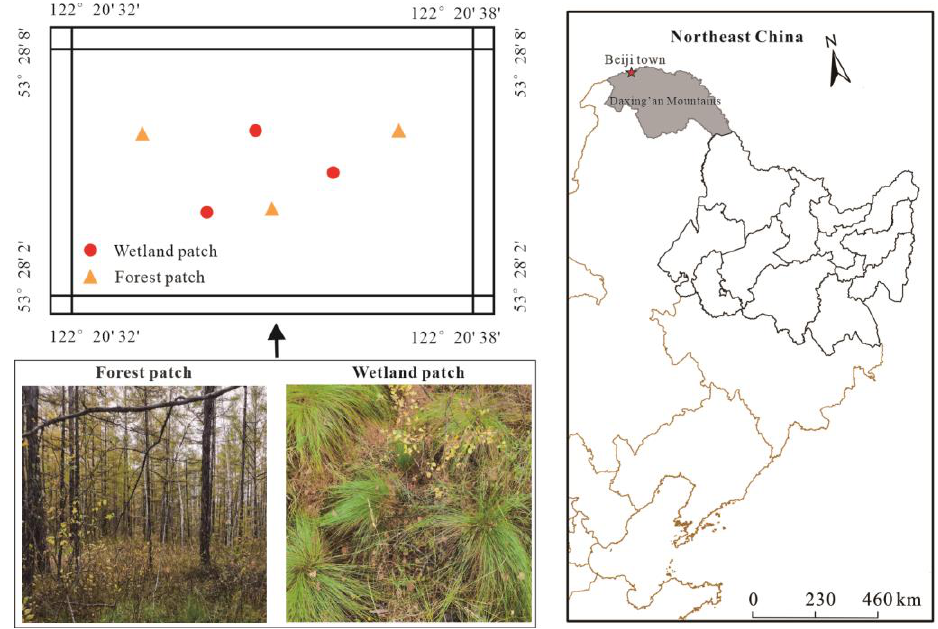
Figure 1. Sampling sites of forest – wetland ecotone in Northeast China.